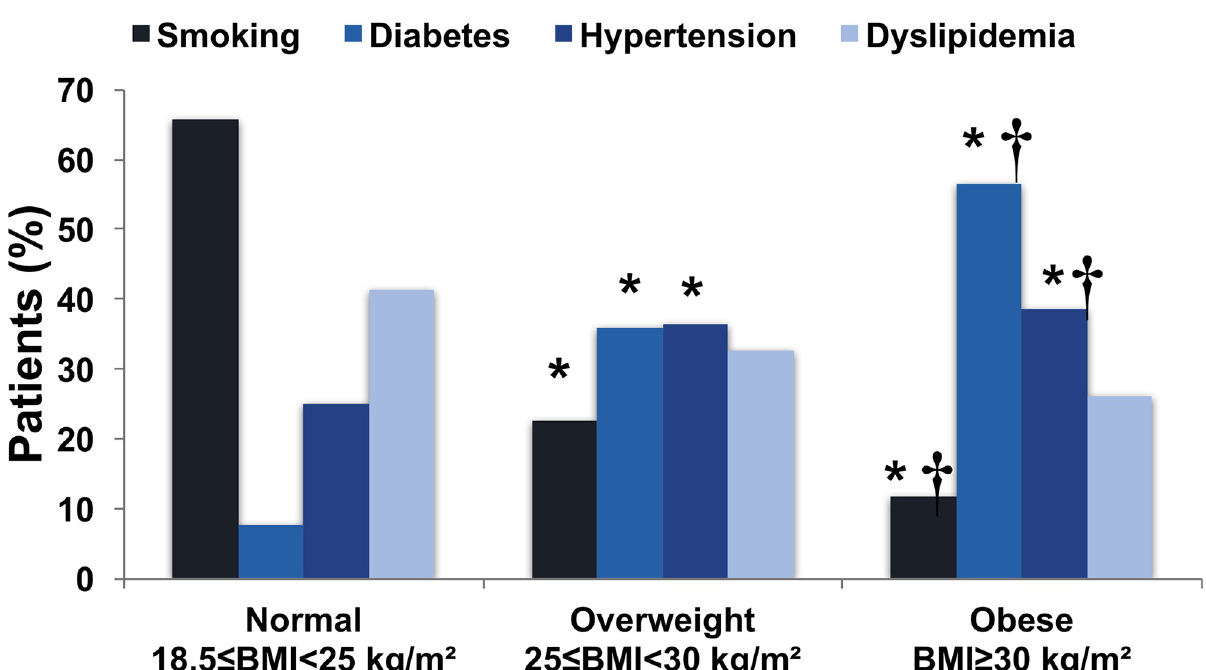
Fig 2. Distribution of cardiovascular risk factors according to body mass index category. � p < 0.05 versus normal weight; † p < 0.05 versus overweight.